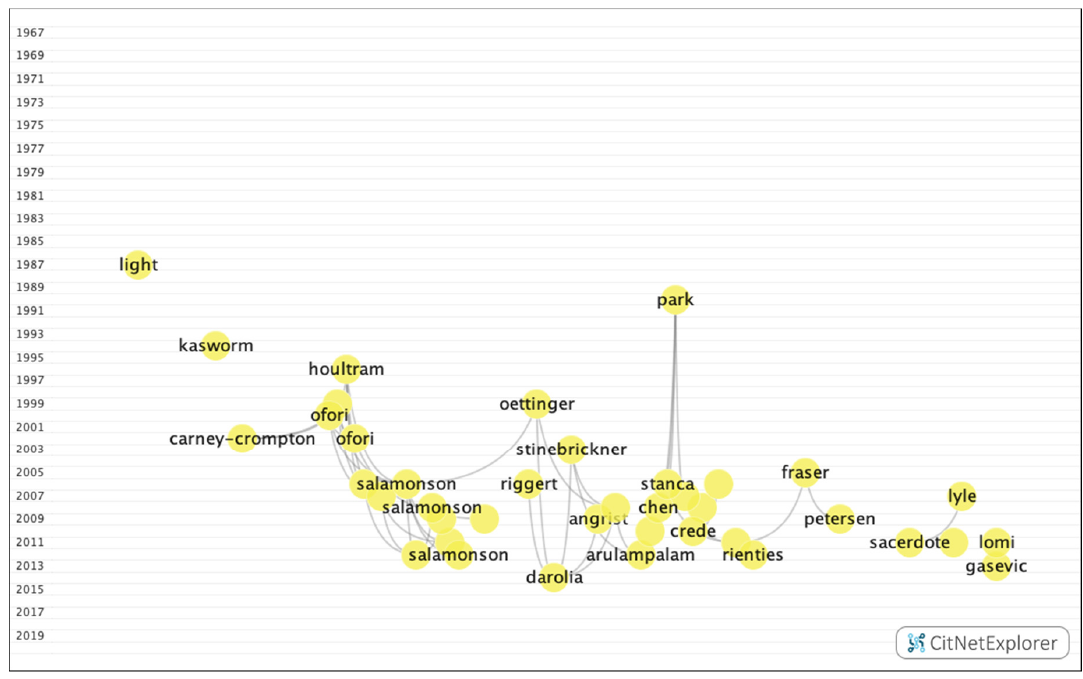
Figure 11. Group 5 citation network.